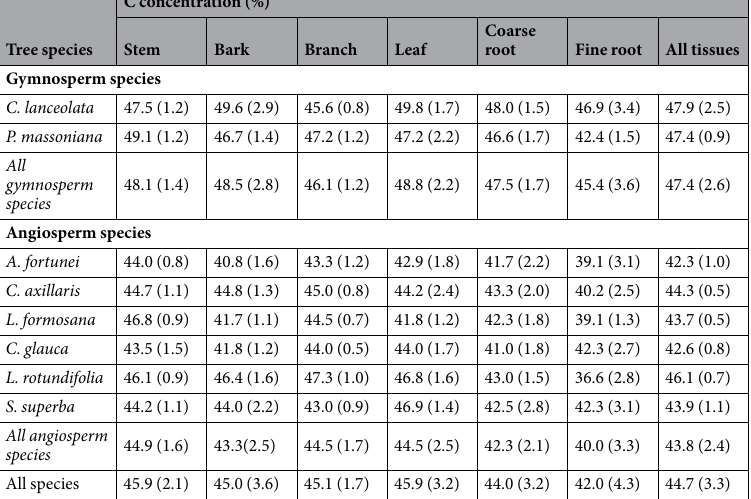
Table 1. Average C concentrations in each tissue of eight subtropical tree species. Standard deviations from the mean are provided in parentheses. Sample size is equal to ten for all species except C. lanceolata where n =